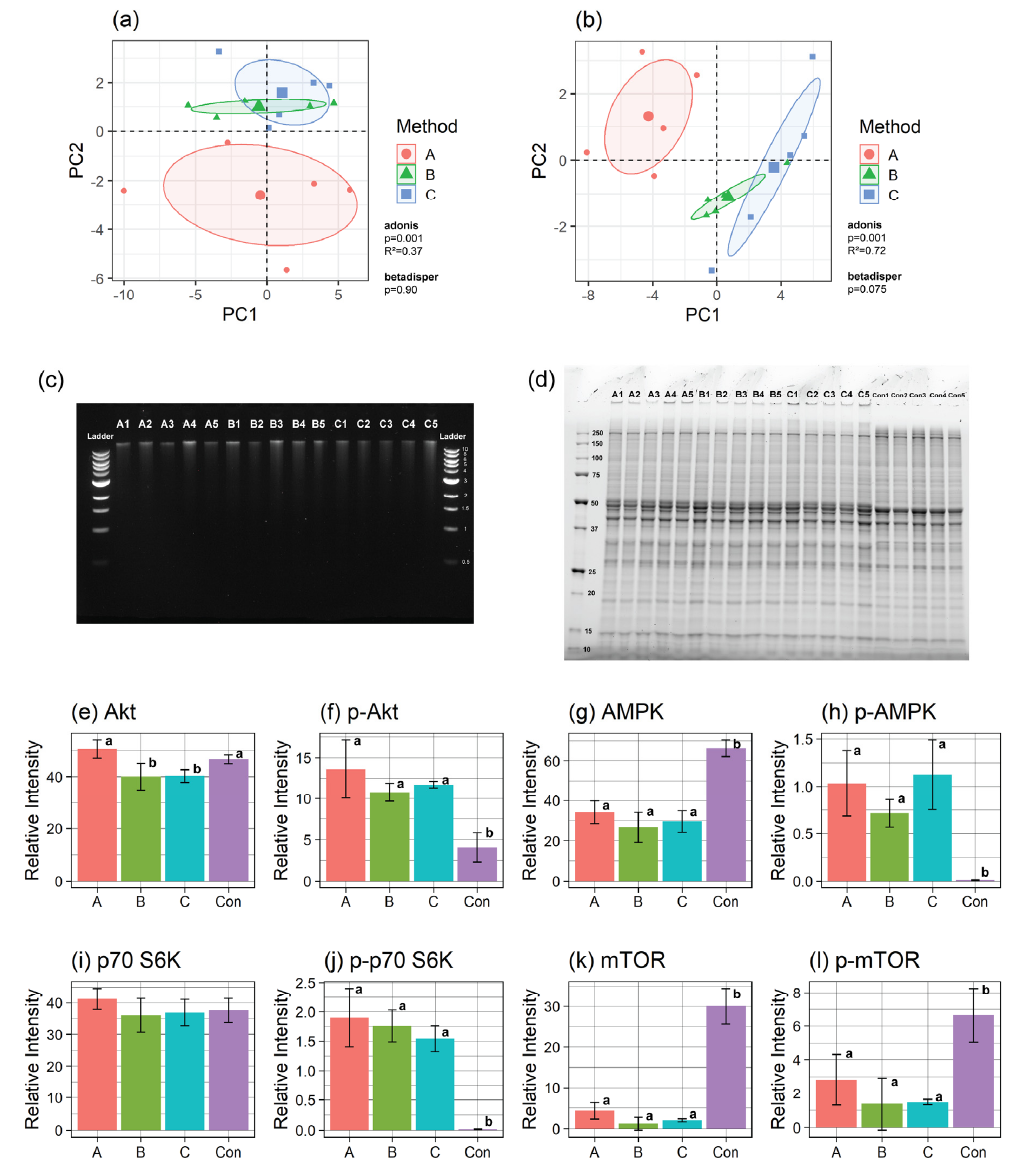
Figure 2. Validation of the extraction methods. PCA plots of the ( a ) polar and ( b ) non-polar metabolomics datasets. Ellipses indicate the 95% confidence interval, and the three larger shapes at the center of each ellipse indicate the centroids of the corresponding metabolite extraction method (Method A (red), Method B (green), Method C (blue). The statistical results from adonis (testing the centroids) and betadisper (testing the data dispersion) tests are included in each plot. ( c ) The result of DNA gel electrophoresis. The molecular weights of the DNA ladder are indicated in kb. ( d ) Result of protein SDS-PAGE. The molecular weights of the protein ladder are indicated in kDa. Bar plots of the relative intensity of total and phospho-protein of Akt ( e , f ), AMPK ( g , h ), p70 S6K ( i , j ), and mTOR ( k , l ), respectively. Different superscript letters indicate significant differences between the groups found by the one-way ANOVA and post-hoc test after multiple comparison testing. Error bars indicate SD of five replicates per extraction method except for Con in ( k ) and ( l ), which were generated from two replicates. For protein analysis, control protein samples were prepared by extracting protein from the same cryoground brain tissue using RIPA extraction buffer. Abbreviations: A1–A5, replicates of Method A; B1–B5, replicates of Method B; C1–C5, replicates of Method C; Con1–Con5 and Con, replicates of control protein